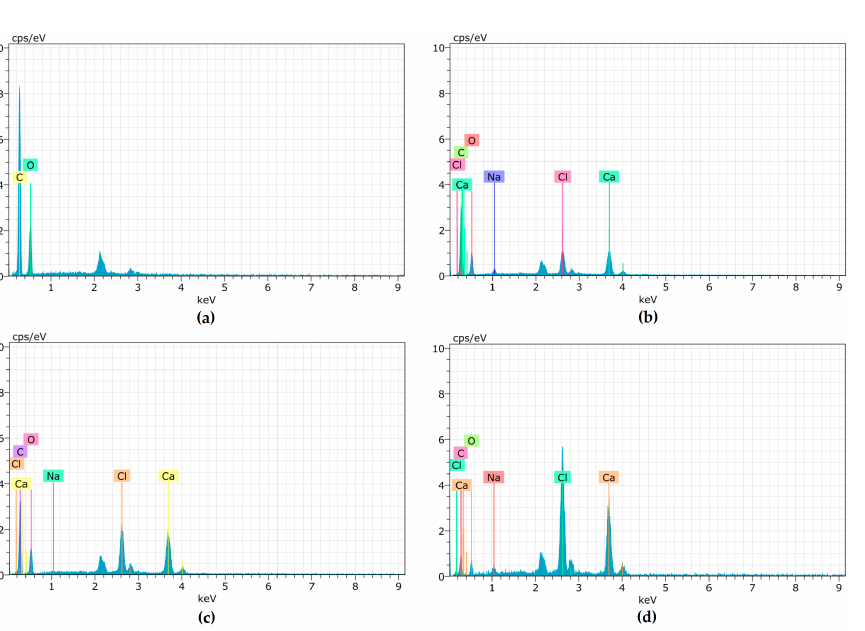
Figure 9. EDX spectra of the cotton/elastane samples coated with CaCl 2 : ( a ) untreated; ( b ) 10 wt % CaCl 2 ; ( c ) 25 wt % CaCl 2 ; ( d ) 50 wt % CaCl 2